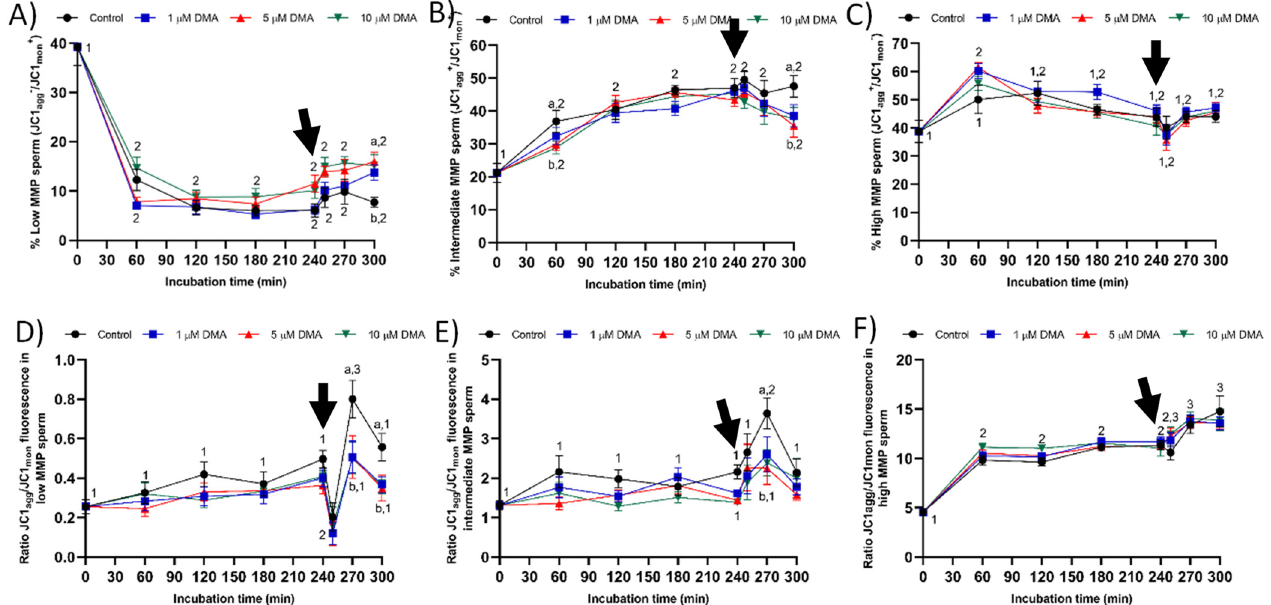
Figure 10. Percentages of sperm with low ( A ), intermediate ( B ), and high ( C ) mitochondrial membrane potential (MMP), and JC1 agg /JC1 mon fluorescence ratio of sperm with low ( D ), intermediate ( E ), and high MMP ( F ) during in vitro capacitation in the control and samples blocked with 1, 5, and 10 µM DMA. Different letter superscripts indicate significant differences between control and blocked samples within a single time point ( p < 0.05); lack of letter superscripts indicate no significant differences between treatments at a single time point ( p > 0.05). Different numeral superscripts indicate significant differences between two consecutive time points within a treatment ( p < 0.05); since the pattern of variation of the percentage of low, intermediate, and high MMP sperm and the ratio JC1 agg /JC1 mon fluorescence in high MMP sperm was similar between control and blocked samples throughout the incubation time, all treatments have the same numeral superscript assigned to each time point. The arrow indicates the addition of 10 µg/mL of progesterone at 240 min of incubation. Results are expressed as the mean ± SEM ( n = 9).